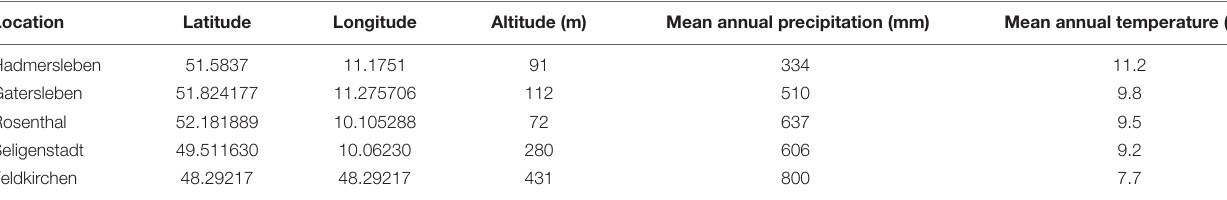
TABLE 1 | Characterization of environments, in which leaf and stripe rust resistance were evaluated. Location Latitude Longitude Altitude